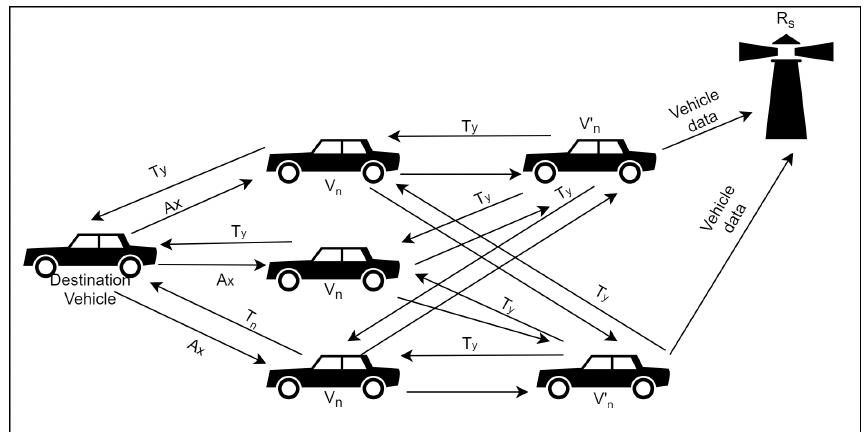
Figure 1. Simulation scenario showing operation of the proposed